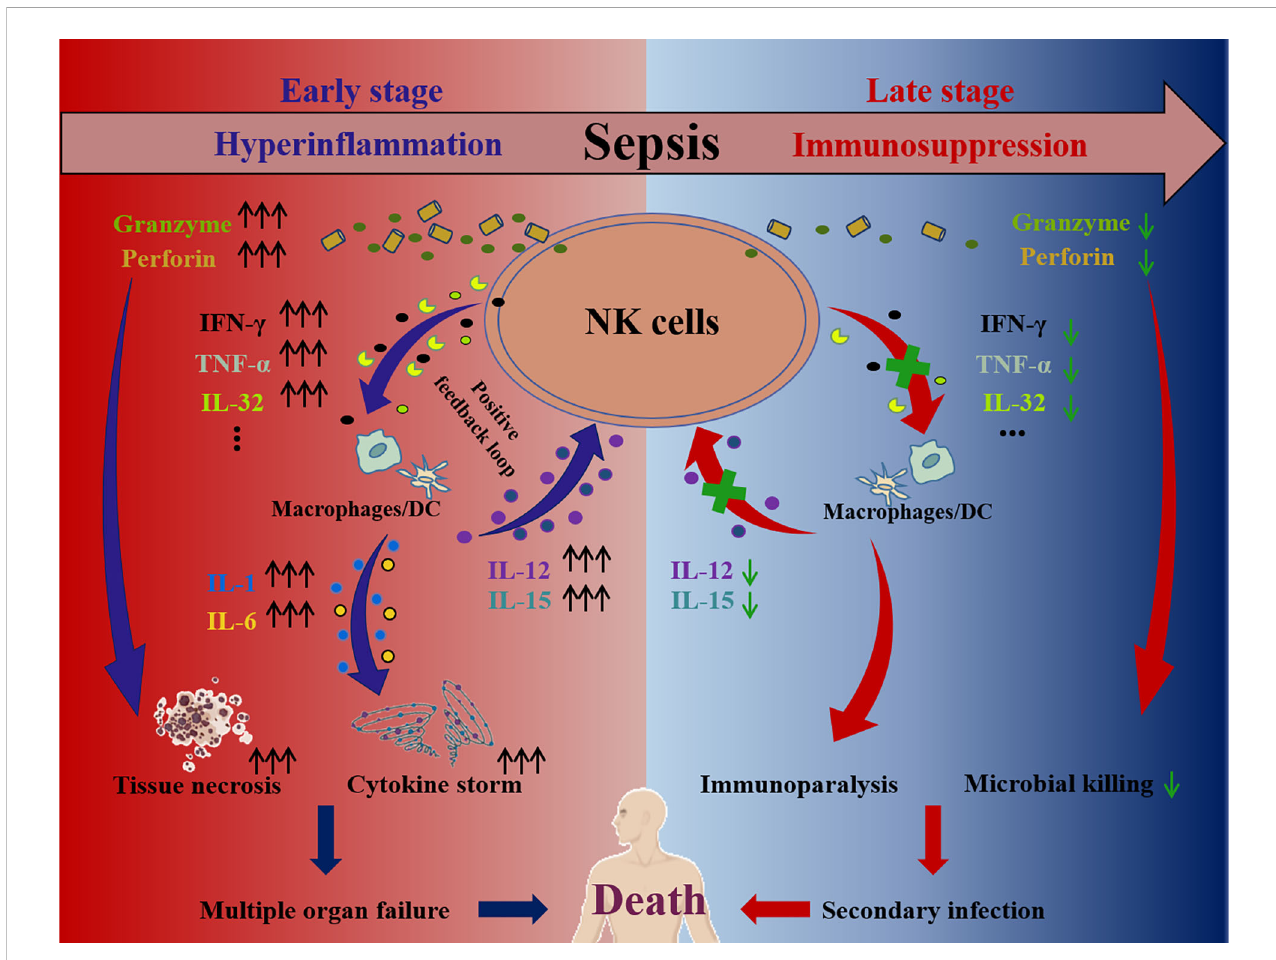
FIGURE 3 The pathological roles of NK cell at the hyperin fl ammation and immunosuppression stage of sepsis. During sepsis hyperin fl ammation, NK cells activation is dysregulated and NK cells secrete abundant cytokines, including IFN- g , TNF- a , IL-32 and so on. These cytokines subsequently facilitate secretion of more cytokines (e.g., IL-12, IL-15, IL-1, IL-6, and so on) by dendritic cells and macrophages, establishing a positive feedback loop and amplifying cytokine storm. Furthermore, cytotoxic proteins (e.g., perforin, granzyme) secreted by NK cells are increased and cause tissue necrosis. As a result, the cytokine storm and tissue necrosis eventually lead to multiple organ failure and death. In contrast, the secretions of cytokines (e.g., IFN- g , TNF- a , IL-32, and so on) and cytotoxic proteins (e.g., perforin, granzyme) of NK cells are impaired at the immunosuppression stage of sepsis, which contributes to the immunoparalysis, causing secondary infection and even